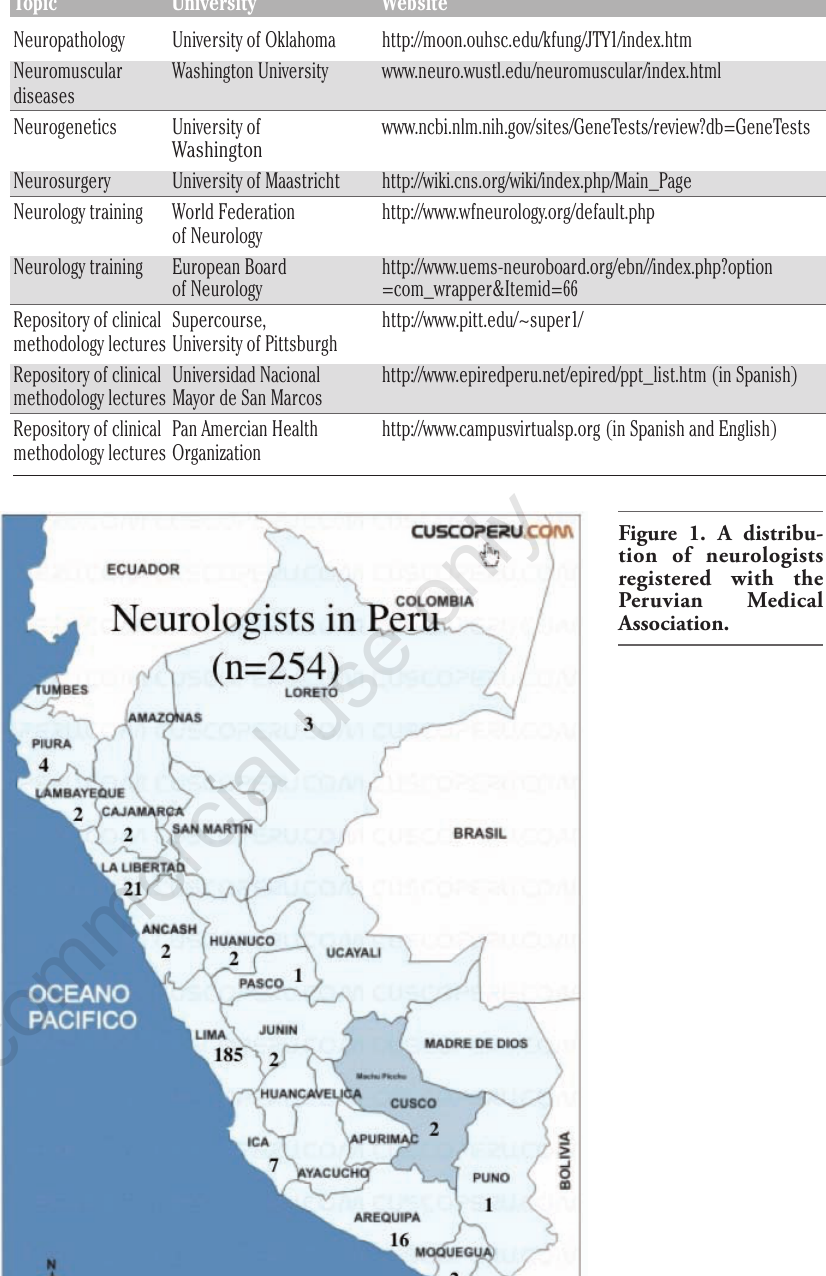
Table 1. Web-based resources for neurology and clinical research methodology.